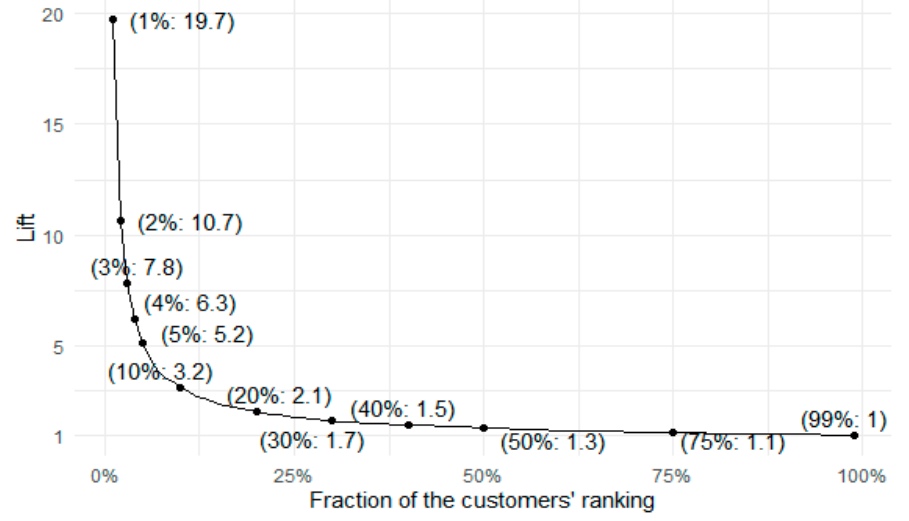
Figure 10. Lift curve for best XGBoost model.